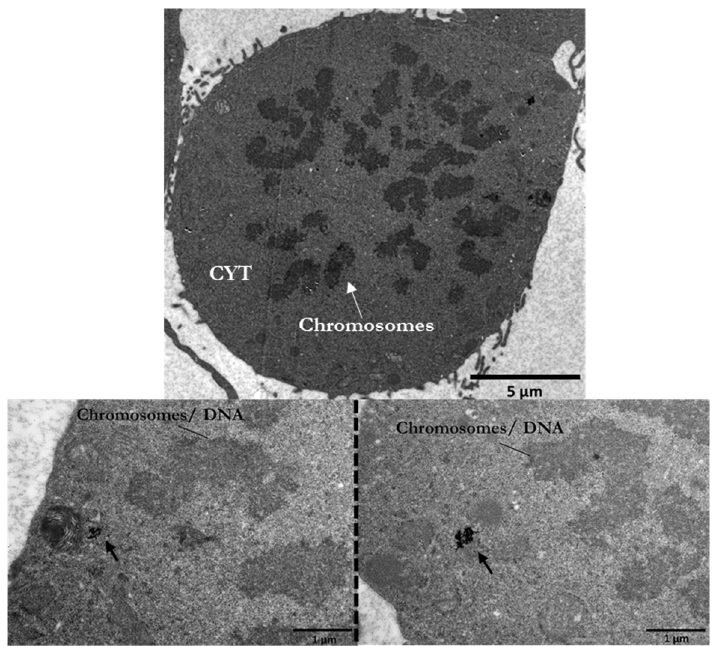
Figure 6. Electron micrographs of a mitotic PC3 cell after treatment with 30 μ g/mL PEG-AuNPs (5 nm). After the nuclear membrane disassembles, AuNPs are much closer to the DNA. CYT: cytoplasm. Scale bars: 5 μ m and 1 μ m.